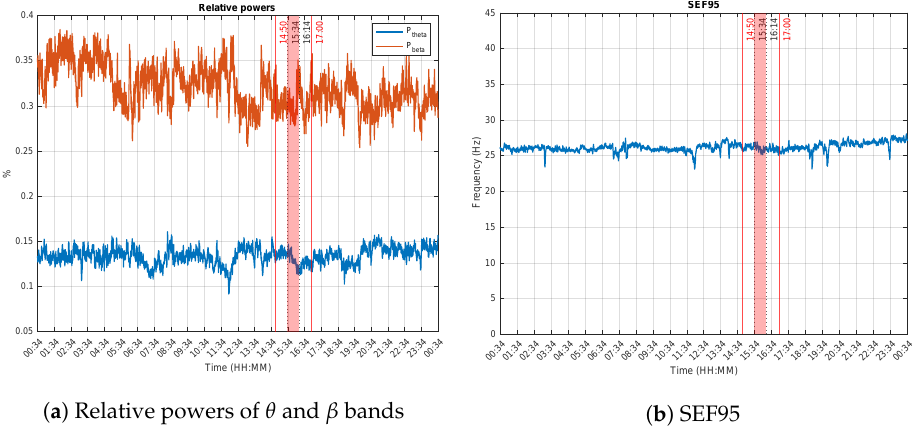
Figure 3. Spectral features. The experiment was performed between 14:50 and 17:00 (red vertical lines). The dotted lines at 15:34 and 16:14 delimit ∆ t , the time during which the experimenter reported that the patient was correctly answering the questions he was asked. Increases in the θ and β powers indicate an increased consciousness level and inversely. The average value of the SEF95 is above 25 Hz ( β band), suggesting that the patient was conscious during the whole recording.